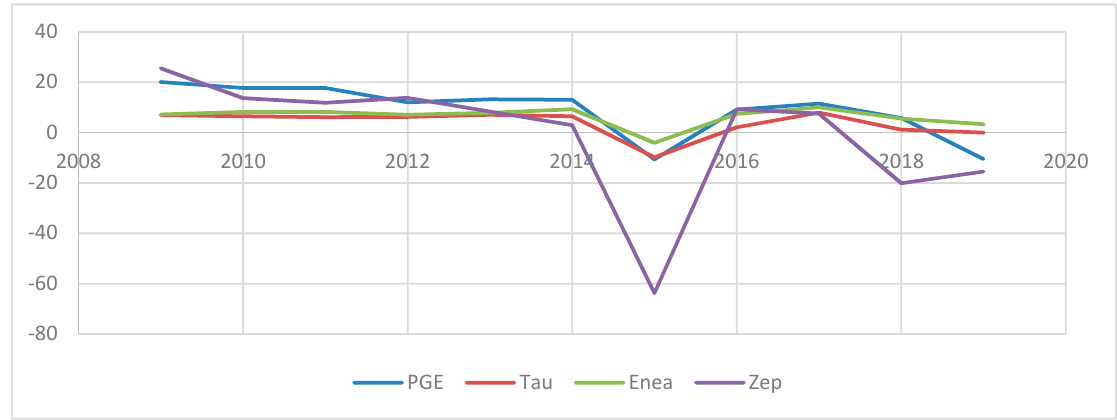
Energies 2021 , 14 , x FOR PEER REVIEW 15 of 25